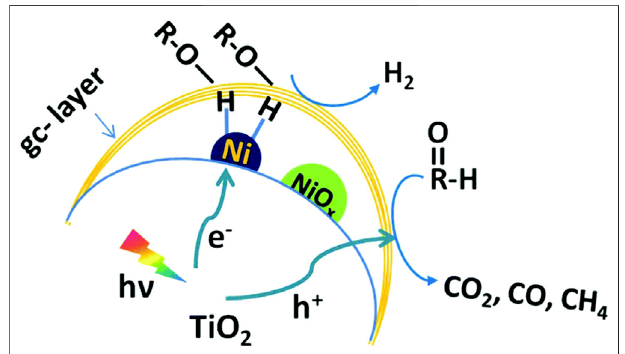
FIGURE 3 | Proposed potential mechanism of the photoreforming of cellulose by TiO 2 /NiO x @C g